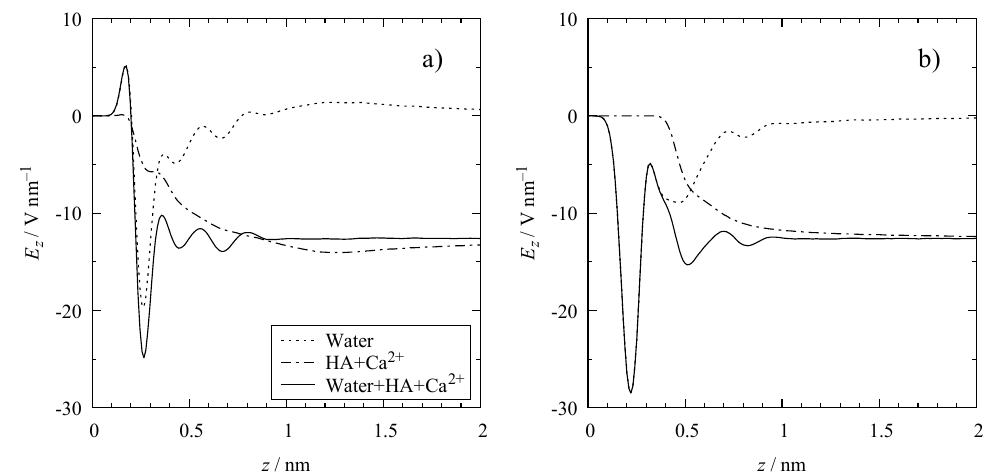
Figure 4. Electric field profiles, E z , due to water, and to the sum of ions (HA+Ca 2+ ) as well as the total electric field (Water+HA+Ca 2+ ) as a function of the perpendicular distance, z , from the aluminol ( a ) and siloxane surfaces ( b ). Basal oxygen atoms of both surfaces are taken as a reference position ( z = 0).